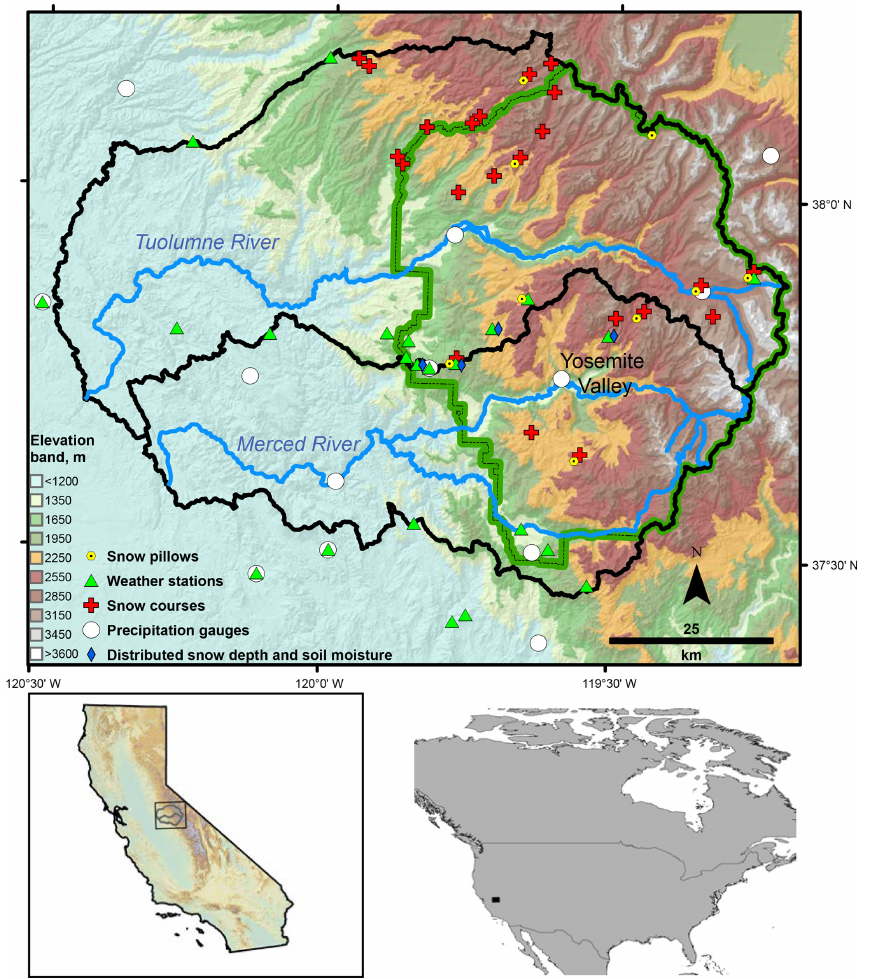
Figure 1. Hydrometeorological stations in and adjacent to the Merced and Tuolumne watersheds used in this data set. Co-located station types are offset for clarity. Yosemite National Park is demarked by the green